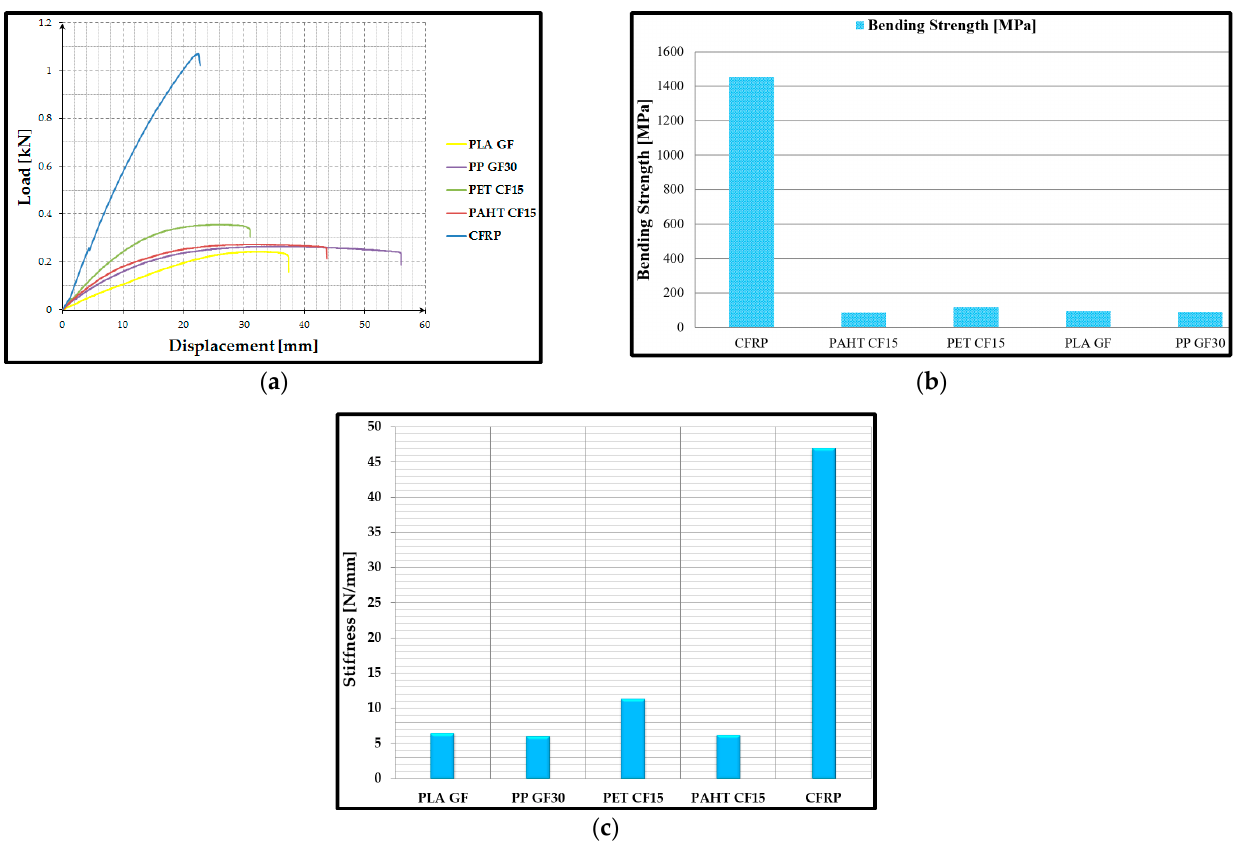
Figure 5. Results after three-point bending tests: ( a ) load–displacement curves; ( b ) bending strength of the tested landing gear; ( c ) stiffness of landing gear